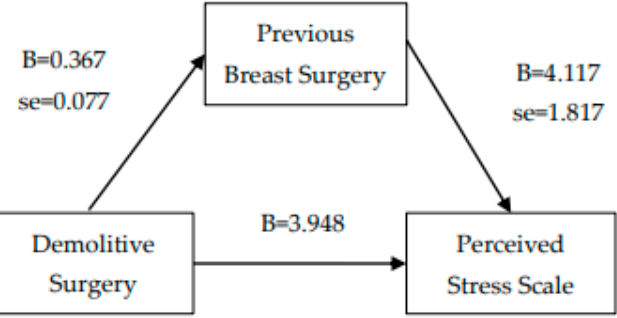
Figure 2. Mediation analysis_2 (Sobel test = 2.046, SE = 0.579, p = 0.041).